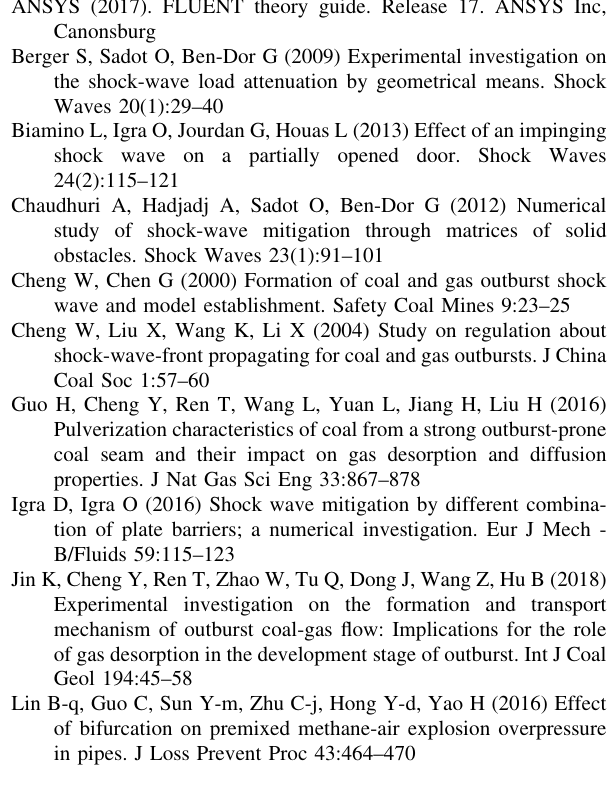
Compliance with ethical standards